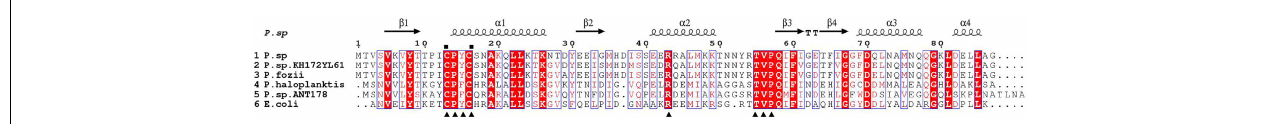
FIGURE 1 | Alignment of the Ps-Grx3 sequence with those of other Grxs. P.sp , Psychrobacter sp. ANT206 Grx3 (GI: MW245063); P.sp. KH172YL61, Psychrobacter sp. KH172YL61 Grx3 (GI: BBI67010); P.fozii , Psychrobacter fozii Grx3 (GI: PYE39608); P. haloplanktis , Pseudoalteromonas haloplanktis Grx3 (GI: OLF76599); P.sp .ANT178, Pseudoalteromonas sp. ANT 178 Grx3 (GI: KF361316); and E.coli , Escherichia coli K-12 Grx3 (PDB ID: 1FOV). The conserved catalytic sites are indicated with squares and the residues involved in GSH binding sites are indicated with triangles.